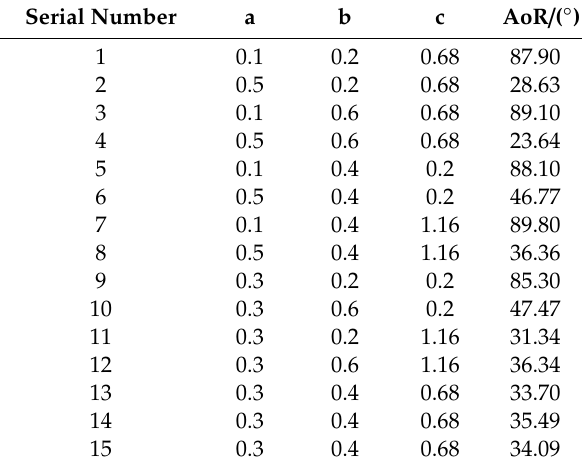
Table 6. Box-Behnken experiment design.